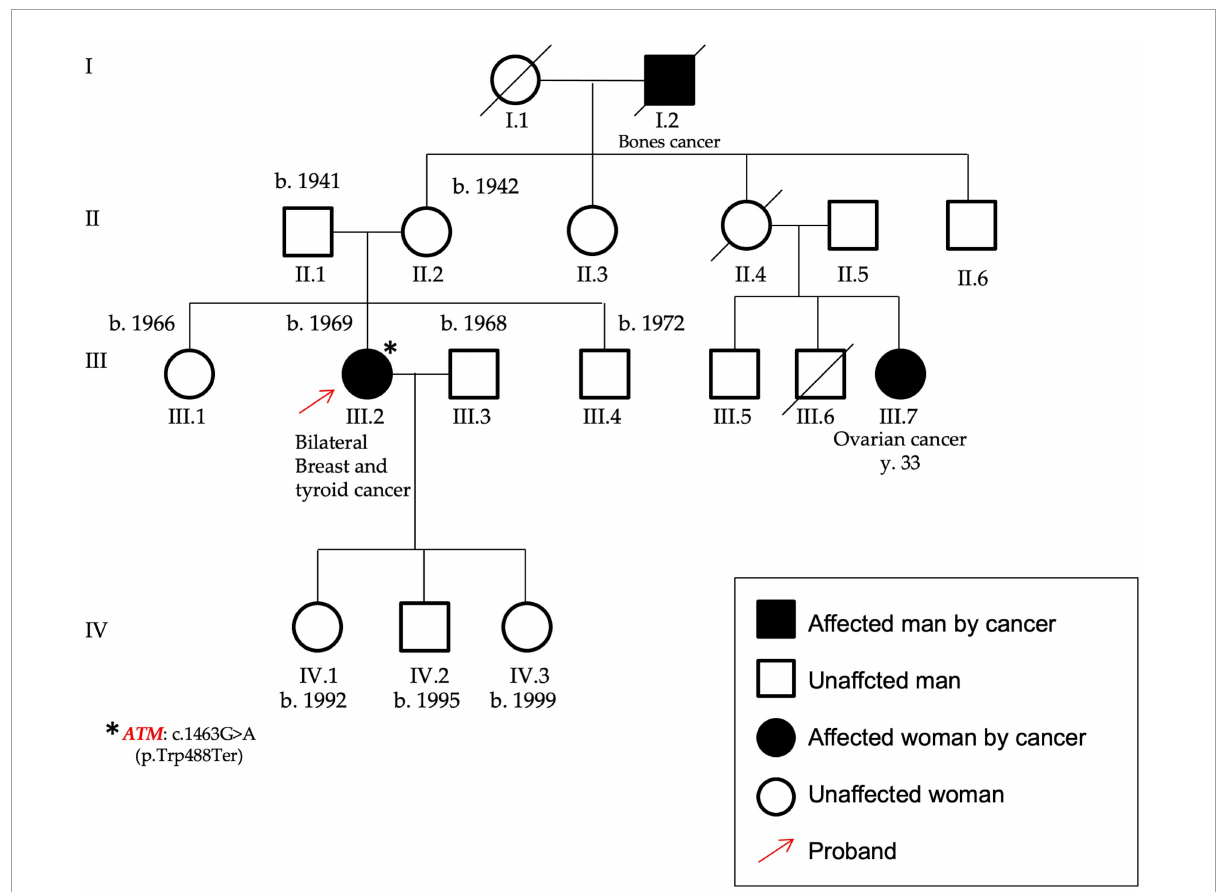
FIGURE3 Pedigree of P12 carrying the variant c.1463G > A, p.(Trp488Ter), found in the ATM gene. The patient was affected by bilateral breast cancer and thyroid cancer and her maternal cousin by early onset ovarian cancer. The variant identified in this proband (highlighted by the red arrow) was a nonsense mutation in the ATM gene, as identified by the